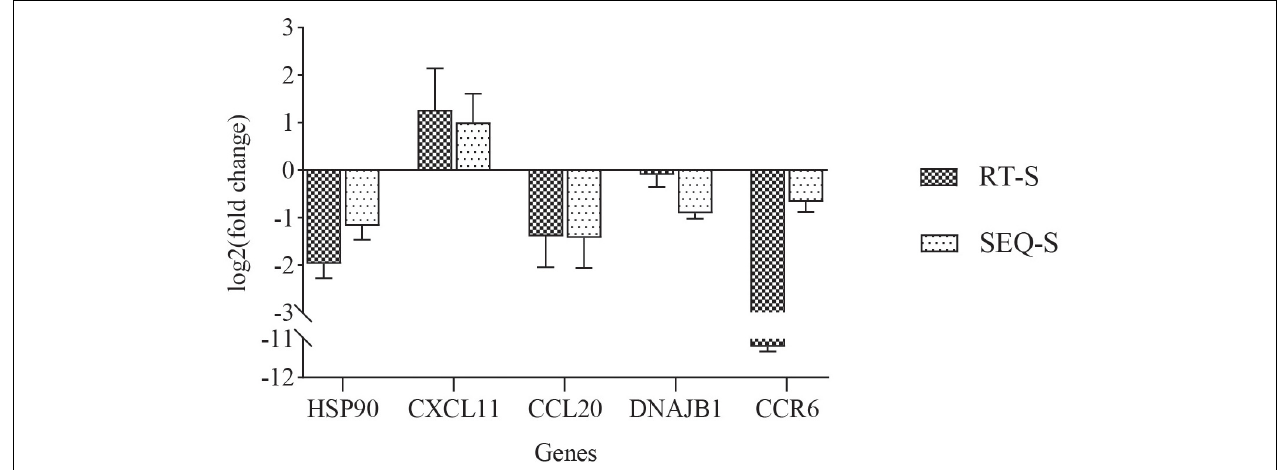
FIGURE 4 | Comparison of the expression profiles of five differentially expressed genes (DEGs) determined by RNA-seq and qPCR in the gill. Each bar indicates the log2(fold change) of a gene’s expression compared to that in the control